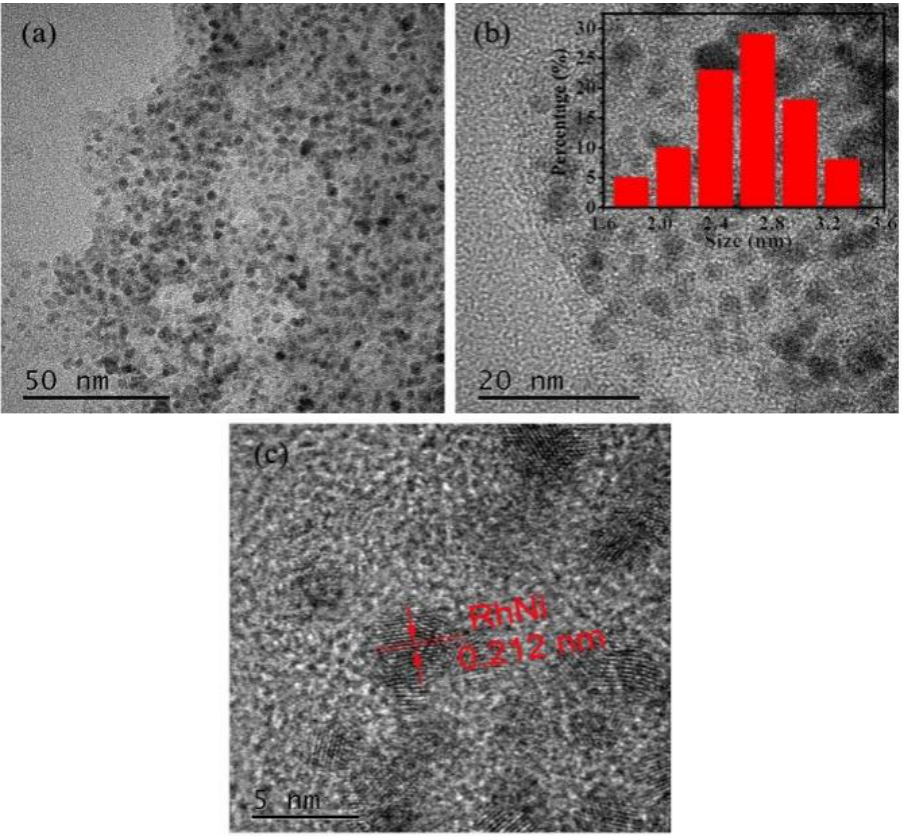
Figure 3. ( a , b ) TEM and ( c ) HRTEM images of the Rh 0.8 Ni 0.2 /MXene. Reprinted with permission from [63]. Copyright 2018 John Wiley and Sons.